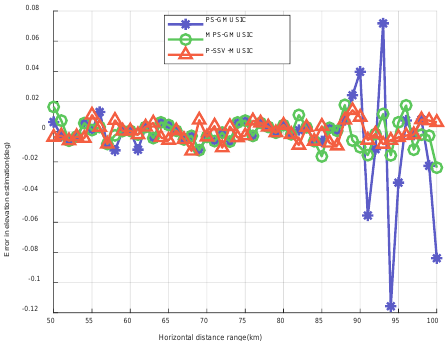
Figure 11. Error results of target elevation measurement.